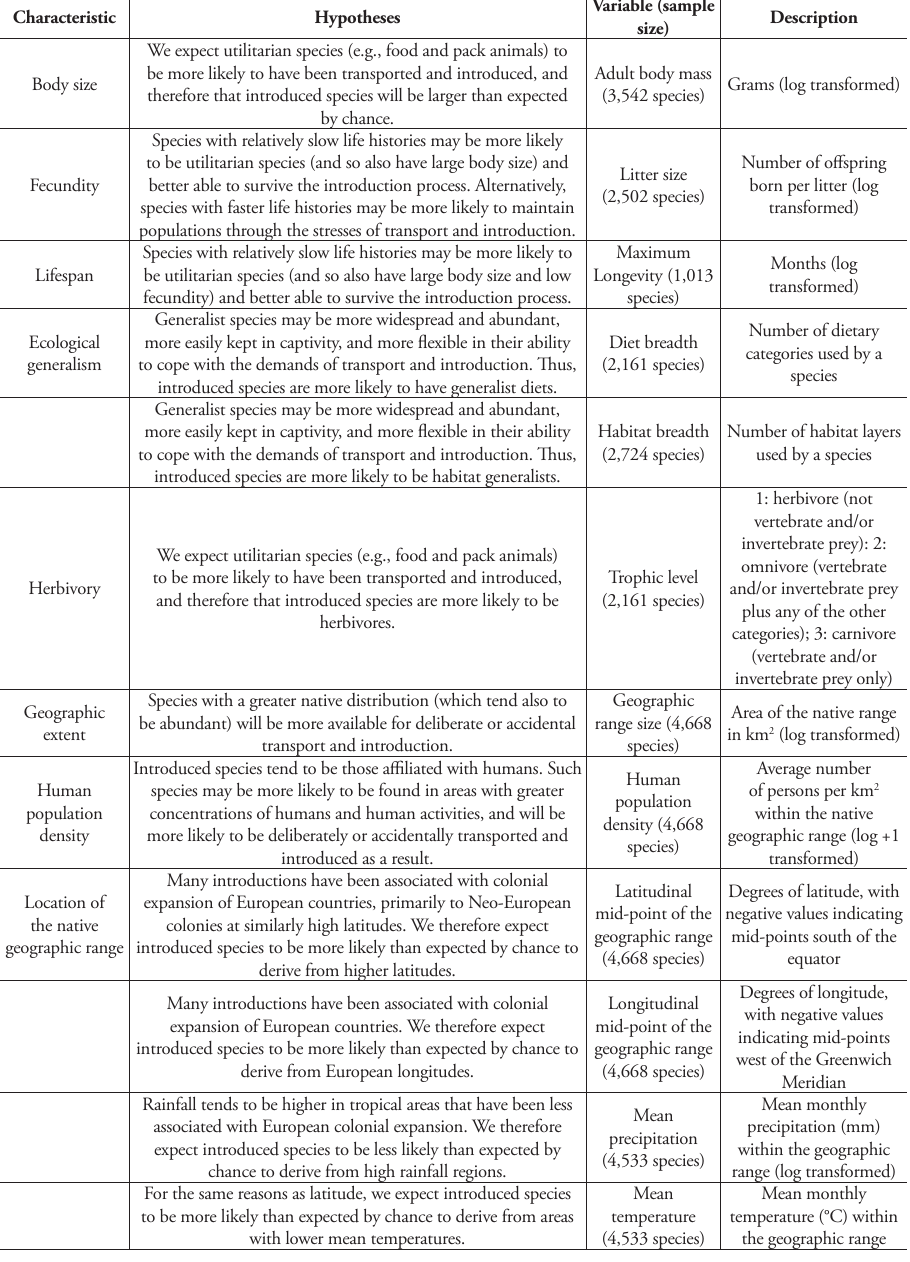
Table 1. The characteristics of species that we expected to influence whether or not mammal species have been introduced, based on patterns of selectivity shown in other taxa (see Introduction for more details), the specific hypotheses associated with those characteristics, the specific variables analysed (with sample size) and a description of that variable (see Methods and Jones et al. (2009) for more